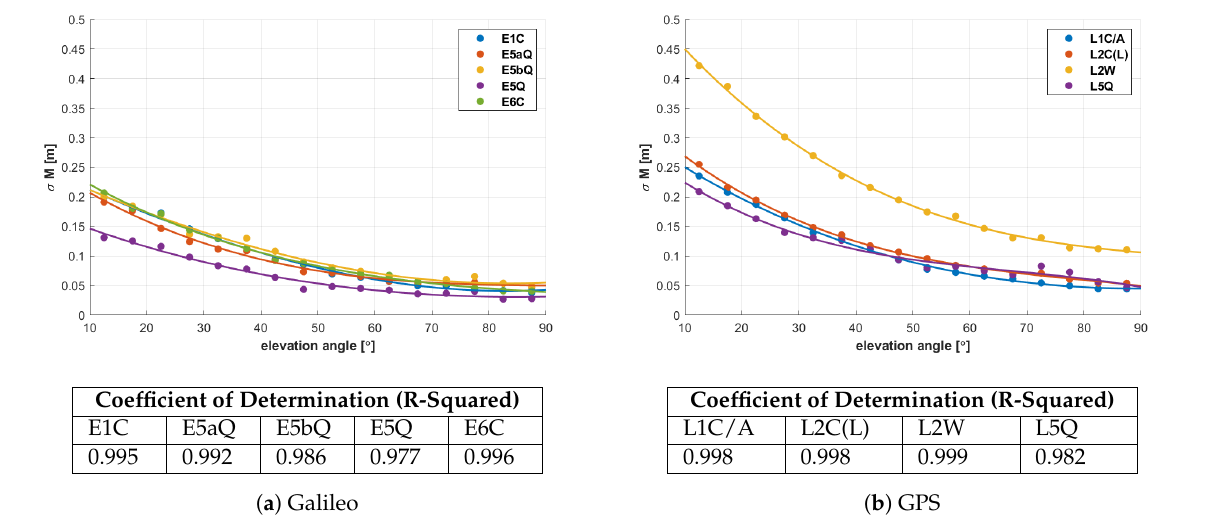
Figure 4. A model of the code multipath error as a function of satellite elevation for ( a ) Galileo and ( b )